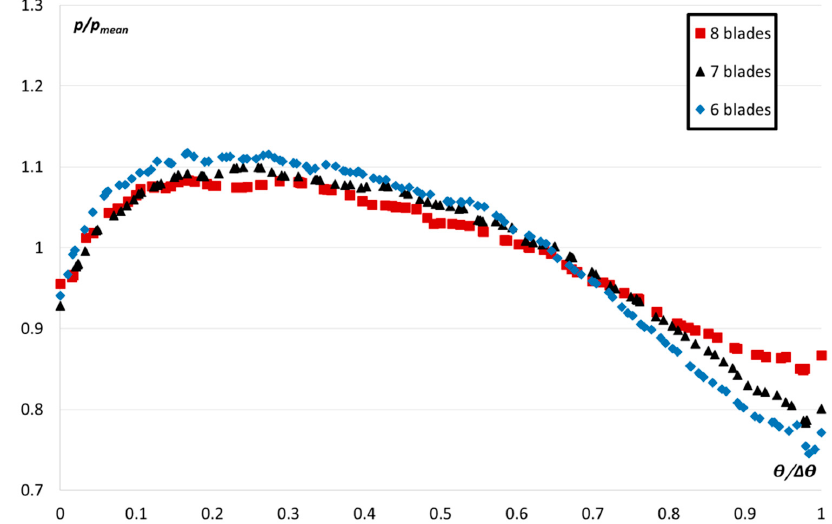
Figure 7. Pressure trends vs. the fraction of each arc from pressure side to suction side along the mean radius at the vane outlet of the three geometries.